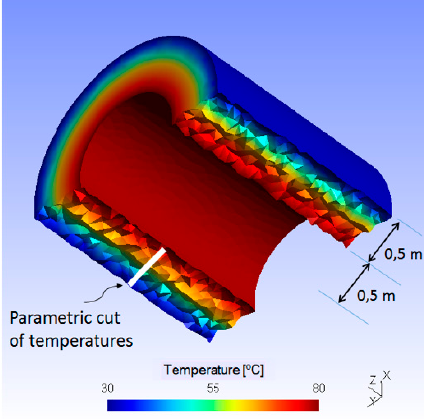
Figure 6. Parametric cut of temperatures in a 3D model with the Cell Method (CM).